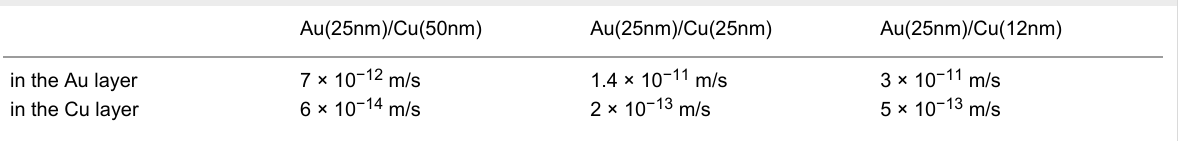
Table 1: Calculated values for the velocity of moving